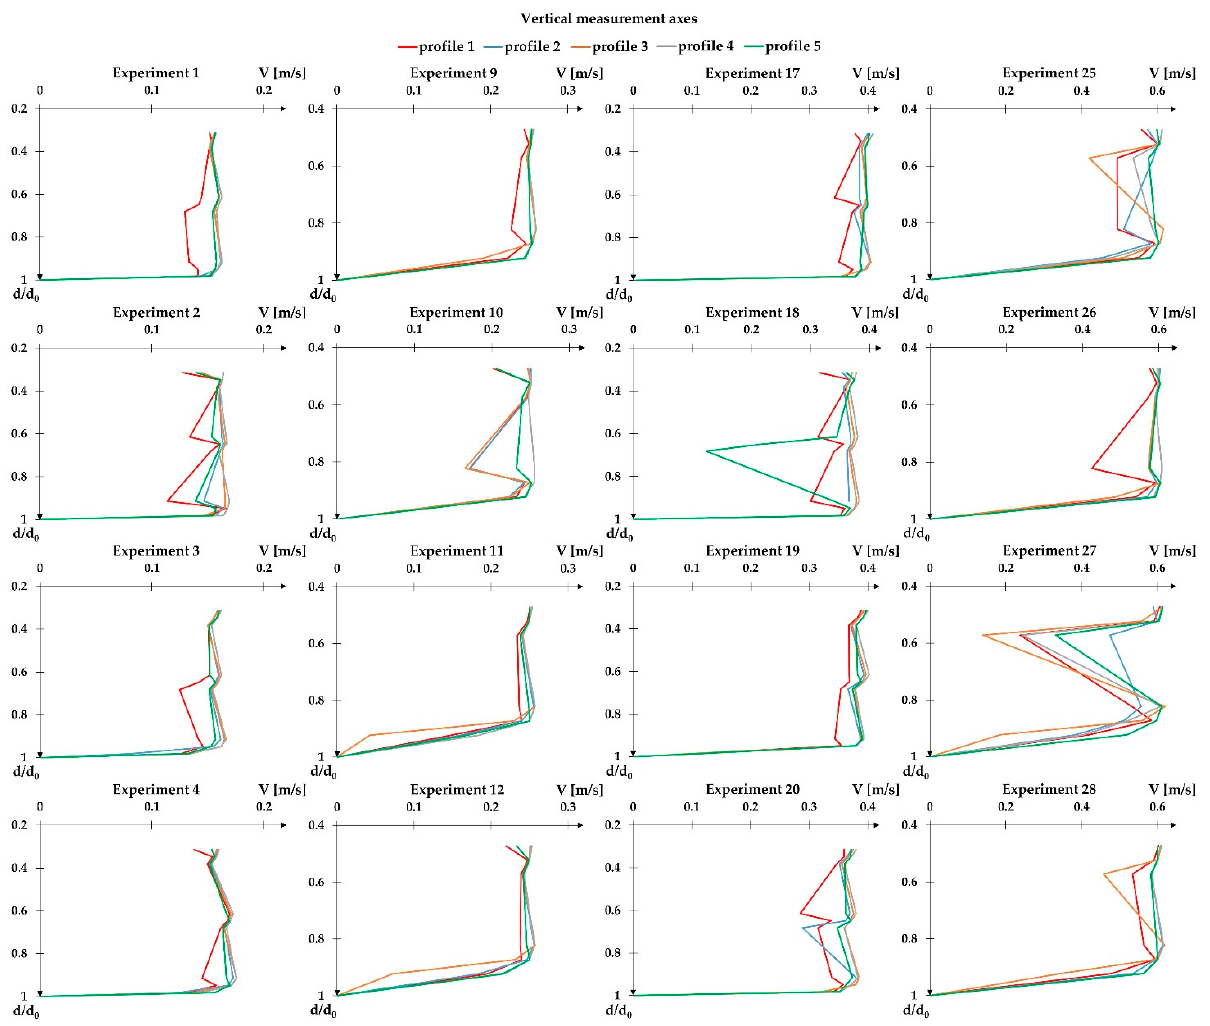
Figure 5. Composite graph of the flow velocity profile for each vertical measurement axis on XS-US for configurations C1–C4 (from top to bottom).